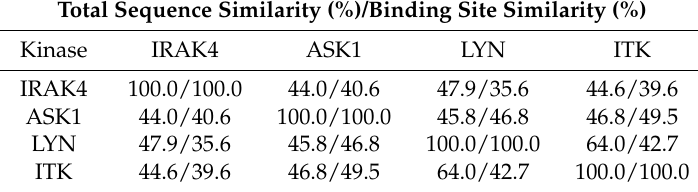
Table 2. Overall protein sequence and binding site similarities of IRAK4, ASK1, LYN, and ITK. Total Sequence Similarity (%)/Binding Site Similarity (%)